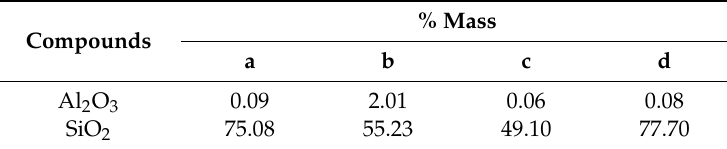
Table 2. Energy Dispersive X-ray Spectroscopy (EDX) test results on the chemical composition of the geothermal waste (this research ( a ); Riyanto et al. [21] ( b ); Fitriyana et al. [22] ( c ); Sulardjaka et al. [16] ( d )).